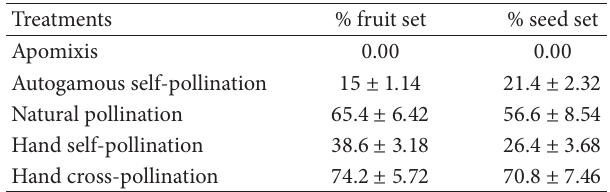
Figure 3: Frequency of pollinators’ visitations in respect to the time of the day. Table 3: Fruit and seed setting following mating system experiment in S.